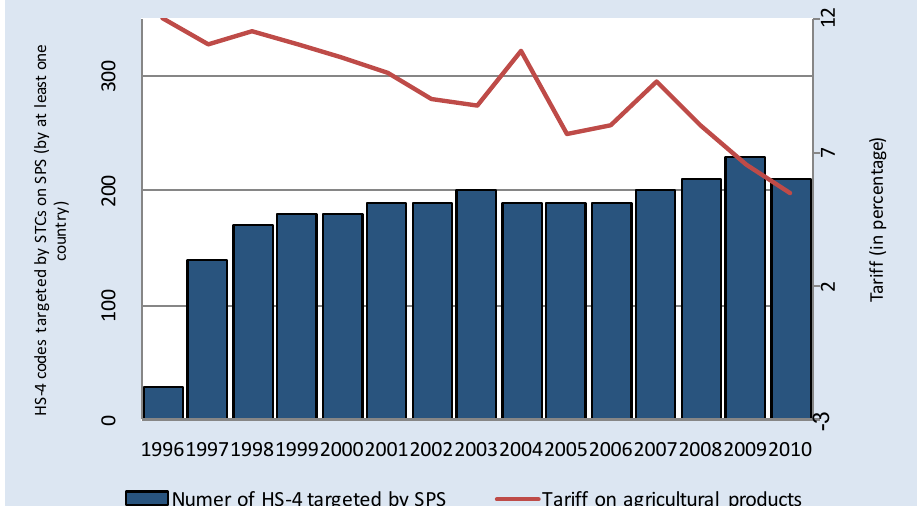
Figure 4. SPS trade concerns and applied tariff level 1996-2010.